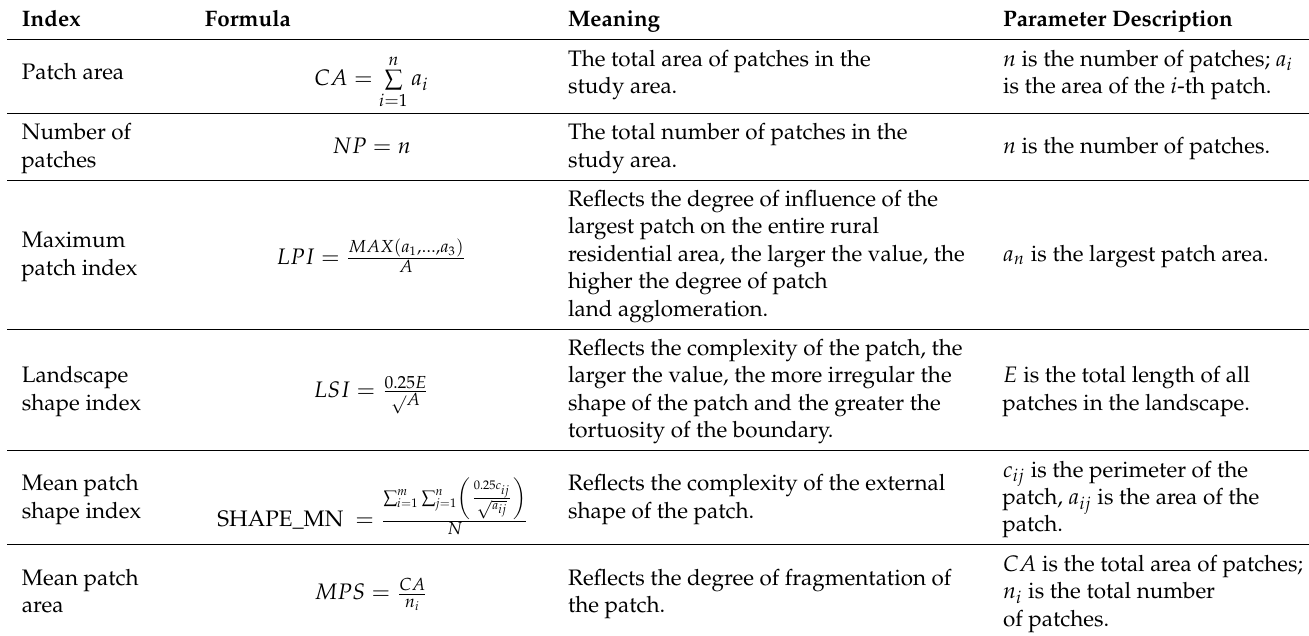
Table 1. Description table of landscape pattern